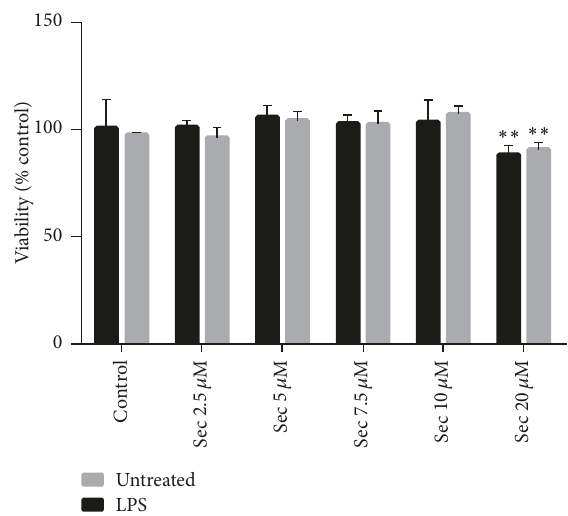
Figure 1: Effects of securinine on the cell viability of the BV2 microglia cell line. BV2 cells were treated with 2.5–20 𝜇 M of securinine without LPS treatment or in the presence of 500 ng/mL LPS treatment for 24 h. Cell viability was measured via the MTT assay and data was expressed as mean ± SEM for three independent experiments. ∗∗ 𝑃 < 0.05 , significantly different from the value in control